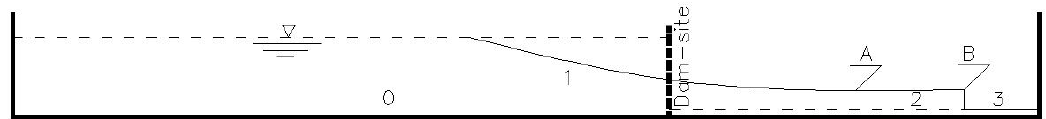
Figure 3. Typical profiles of the dam-break flow regimes for Stoker’s analytical solution [9]: Wet-bed downstream.